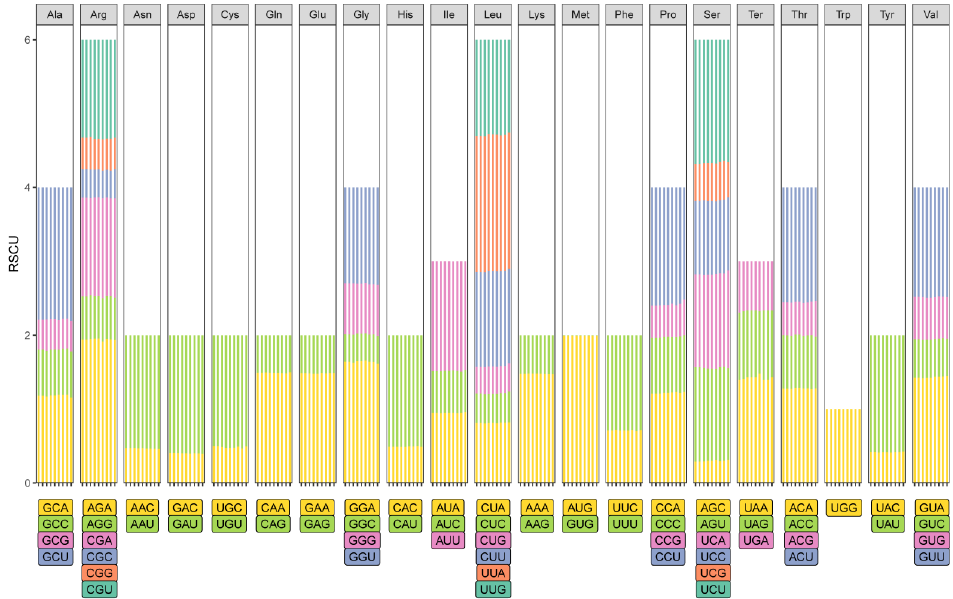
Figure 5. Relative synonymous codon usage (RSCU) analysis in chloroplast genes of Caladium spe-